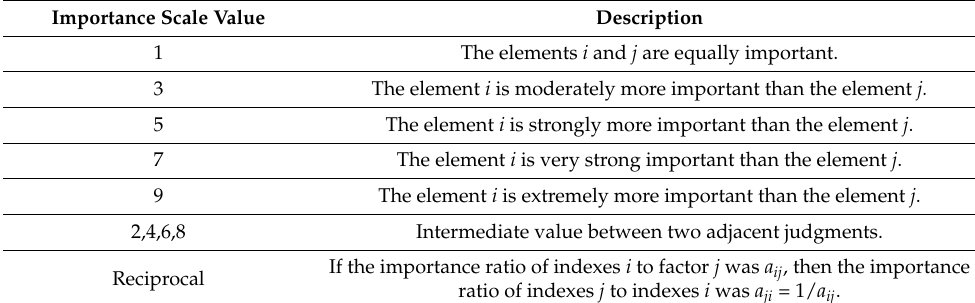
Table 1. Importance scale